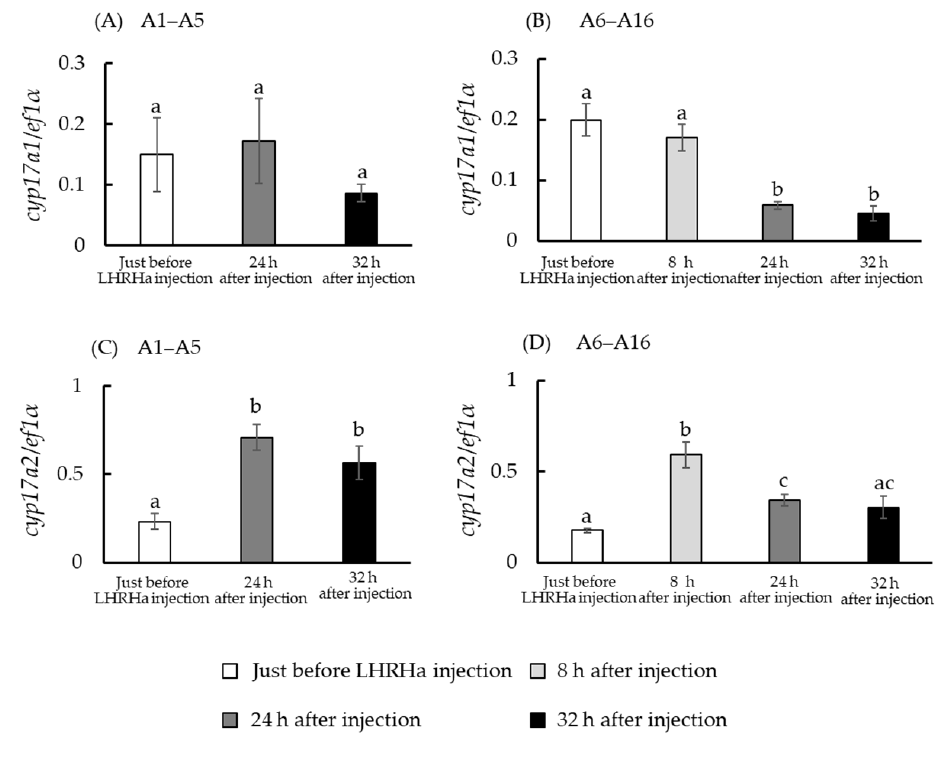
Figure 5. cyp17a1/2 mRNA levels of ovarian follicles. Levels in individuals (A1–A16) just before (white column), and 8 h (light gray column), 24 h (dark gray column), and 32 h (black column) after injection. Some individuals (A1–A5) did not reach ovulation, while other individuals (A6–A16) did. Panels ( A , C ) show cyp17a1 and cyp17a2 mRNA levels between individuals A1–A5. Panels ( B , D ) show cyp17a1 and cyp17a2 mRNA levels between individuals A6–A16. Different letters represent a significant difference among groups ( p < 0.05).